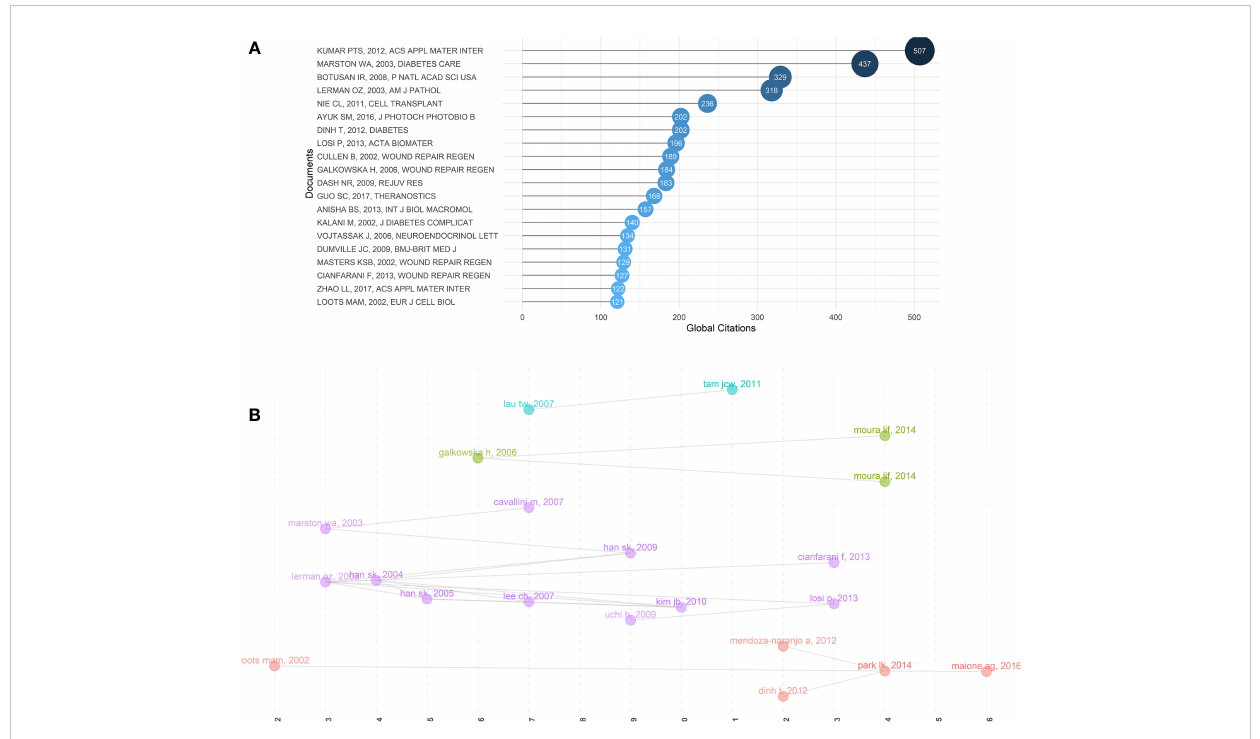
FIGURE 4 Relationship between high-impact literature and historical evolution and hotspots. (A) The top 20 most global cited documents of fi broblast-related DFUs research. (B) Visualized historical direct citation network based on the evolution trend of fi broblast-related DFUs research from 2000 to 2022. Each node represents a piece of literature, and the lines between the nodes indicate the citation relationships between